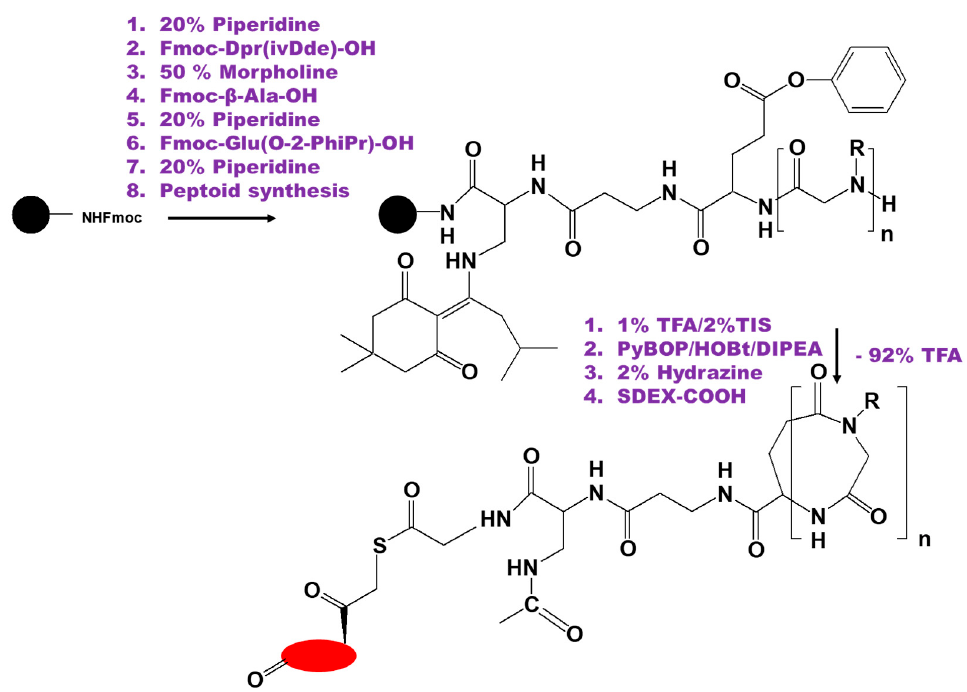
Figure 5. Scheme of the solid-phase synthesis of dexamethasone-peptoid conjugate [82].